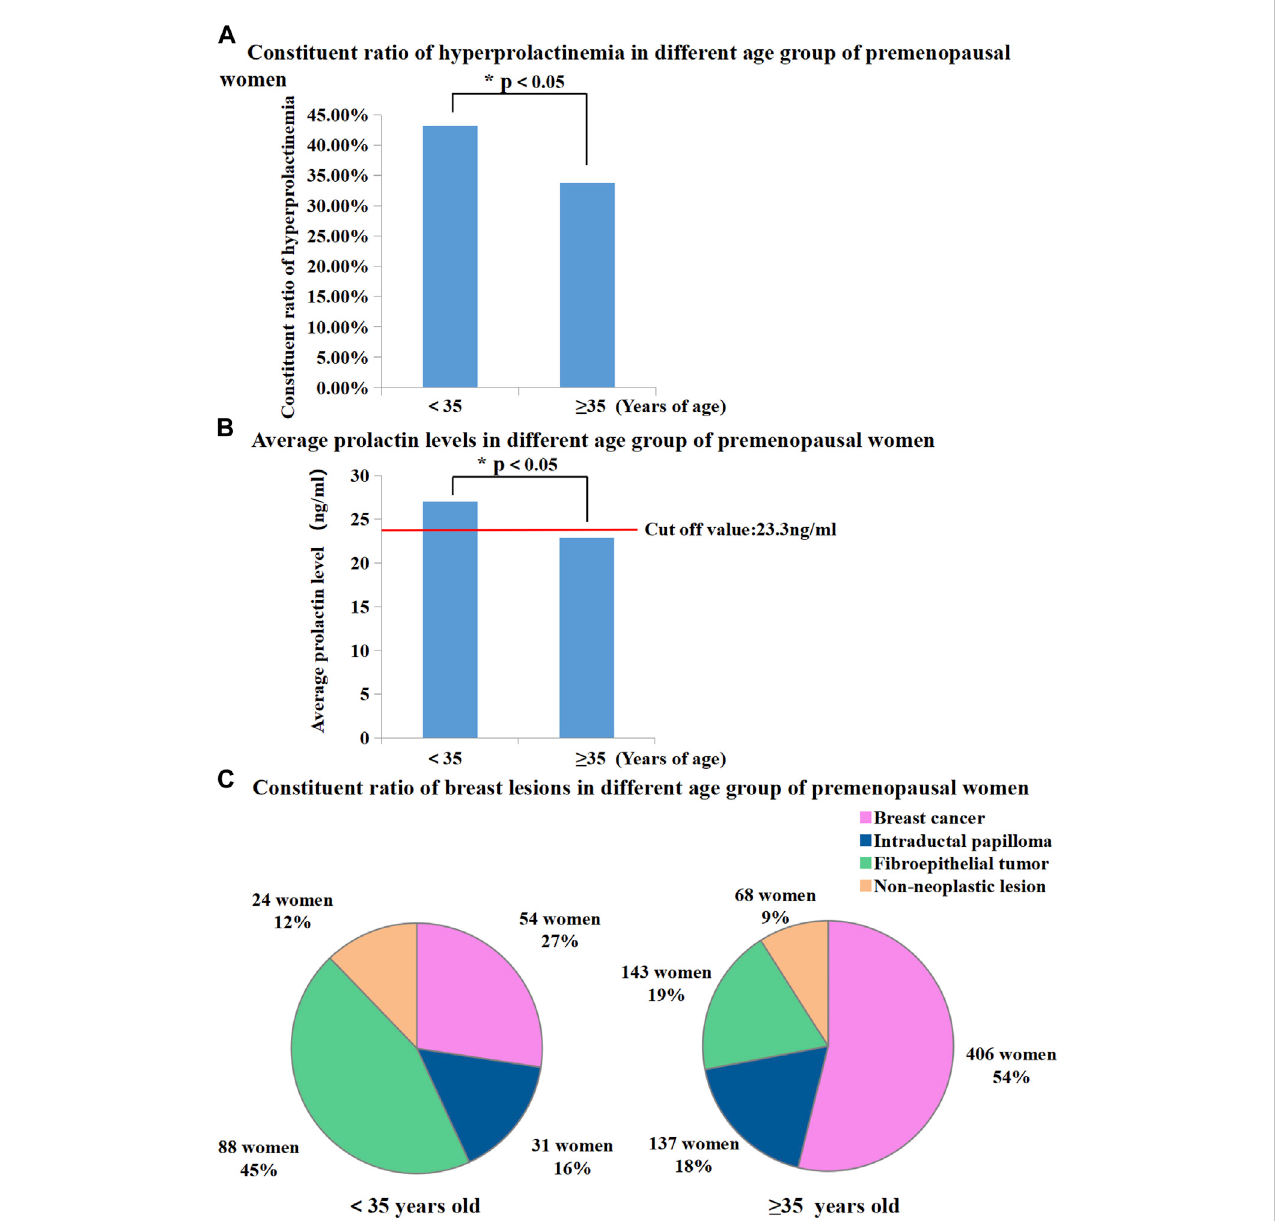
FIGURE 3 (A) Proportion of hyperprolactinemia was signi fi cantly different between premenopausal women younger than 35 and older than 35 (43.15% vs. 33.82%, p < 0.05); (B) Average prolactin levels were signi fi cantly different between premenopausal women younger than 35 and older than 35 (27.03 ng/mL vs. 22.86 ng/mL, p < 0.01); (C) Proportion of breast diseases in different age group of premenopausal